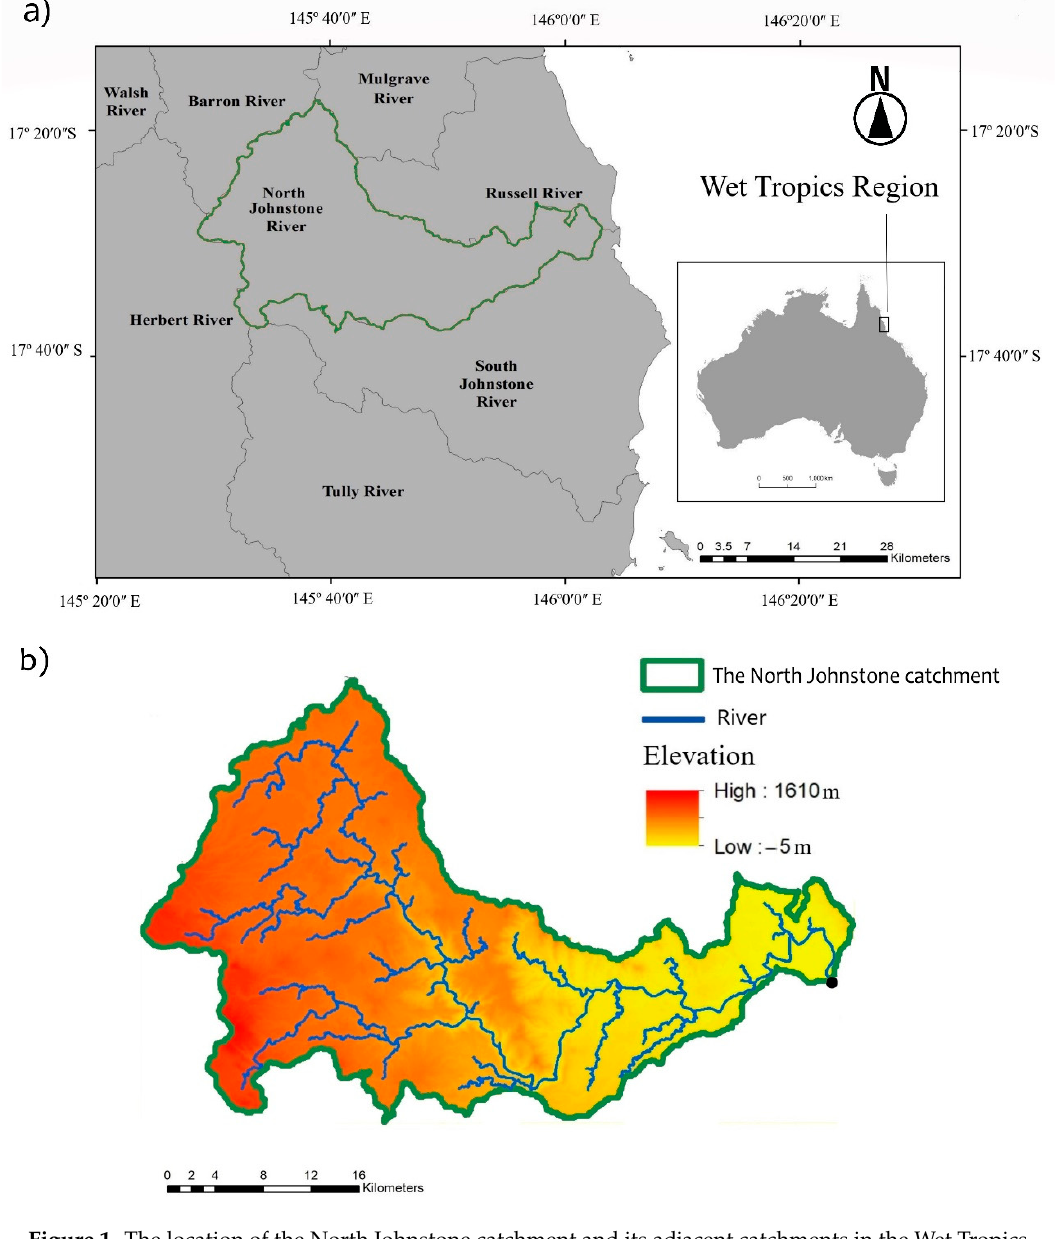
Figure 1. The location of the North Johnstone catchment and its adjacent catchments in the Wet Tropics Region ( a ) and the upscaled North Johnstone catchment showing its river network and elevation gradient ( b ).